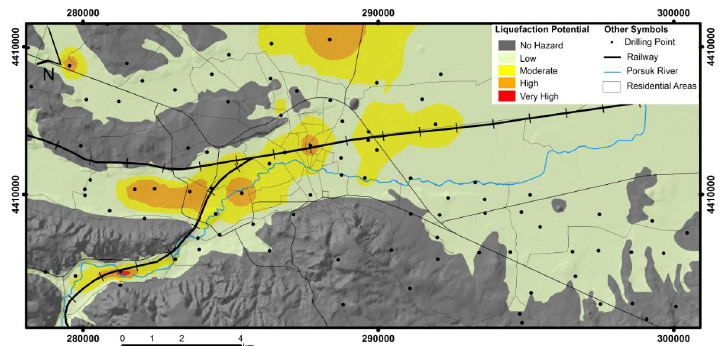
Figure 7. Liquefaction potential map acquired through the IDW method.